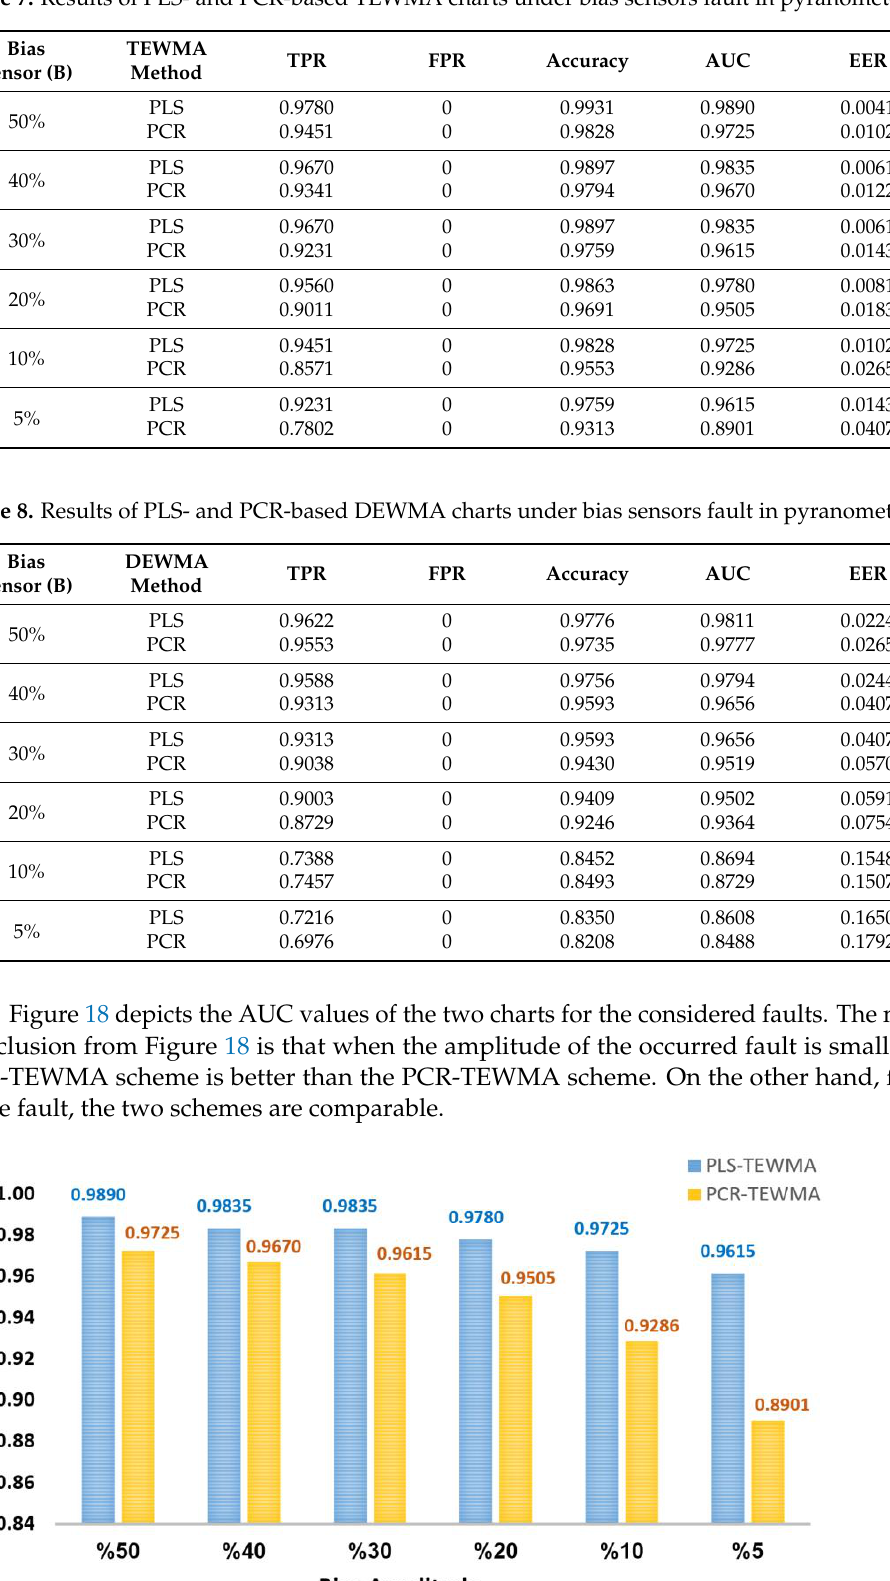
Table 7. Results of PLS- and PCR-based TEWMA charts under bias sensors fault in pyranometer.